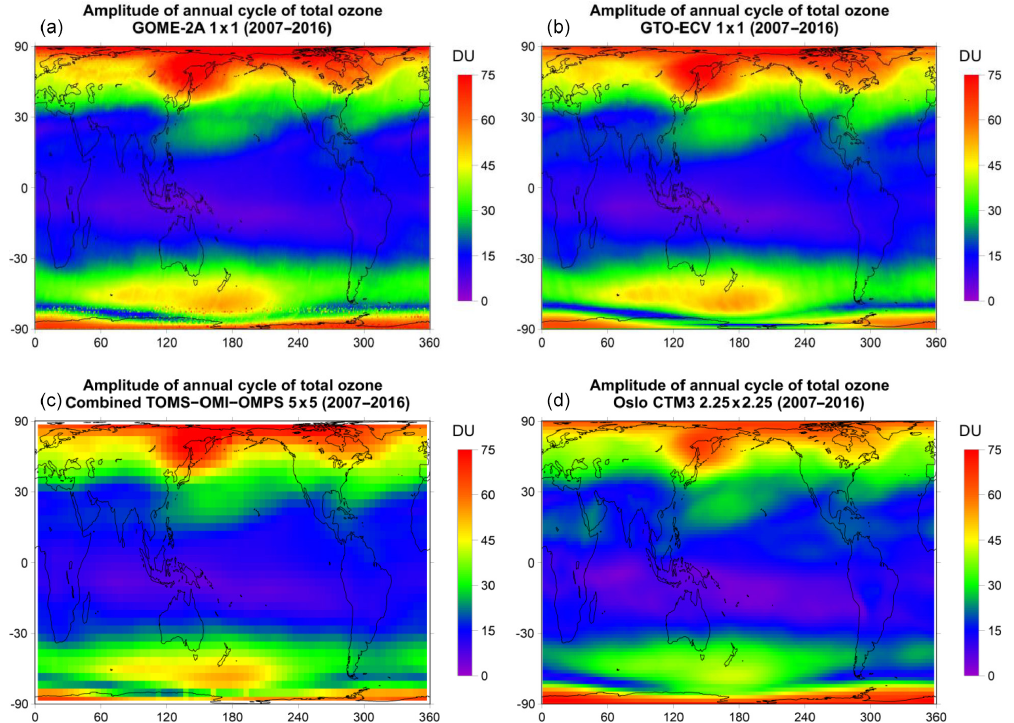
Figure 4. Comparison of the amplitude, i.e. (maximum value – minimum value)/2, of the annual cycle of total ozone from GOME-2A (a) with the amplitude of the annual cycle of total ozone from GTO-ECV (b) , the combined TOMS–OMI–OMPS satellite data (c) , and Oslo CTM3 model simulations (d)